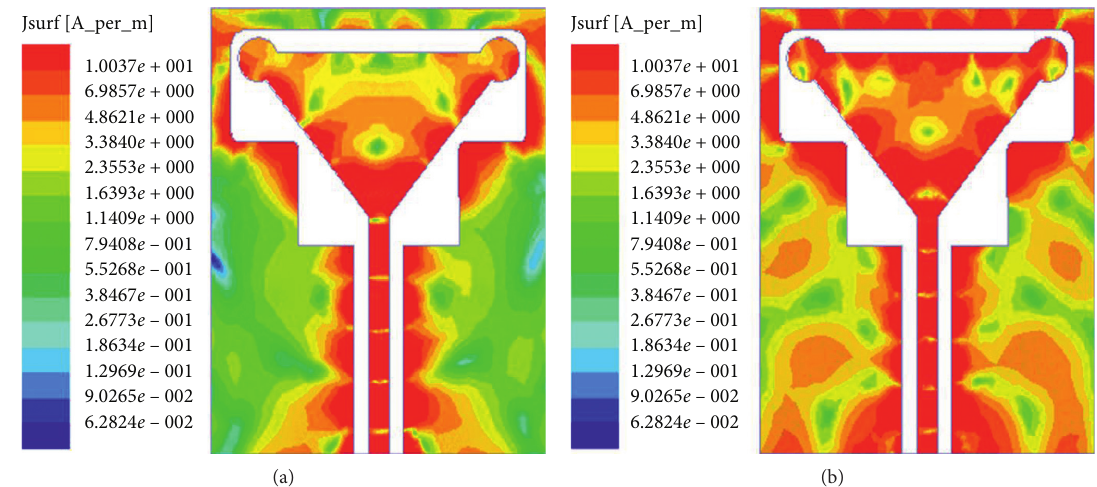
Figure 4: Surface current distribution. (a) @first resonance 9.9GHz. (b) @second resonance 10.8GHz.